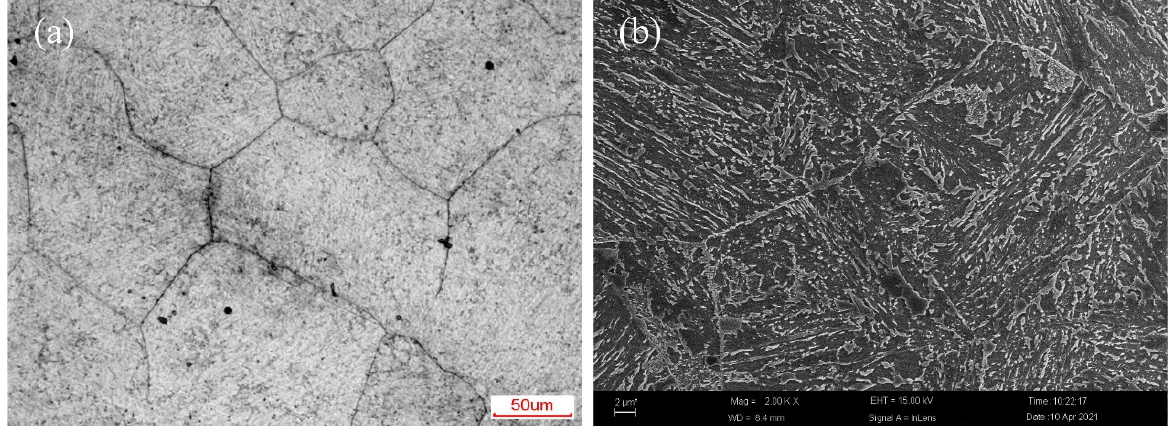
Figure 2. ( a ) initial grain size and ( b ) morphology of the SDP1 steel.